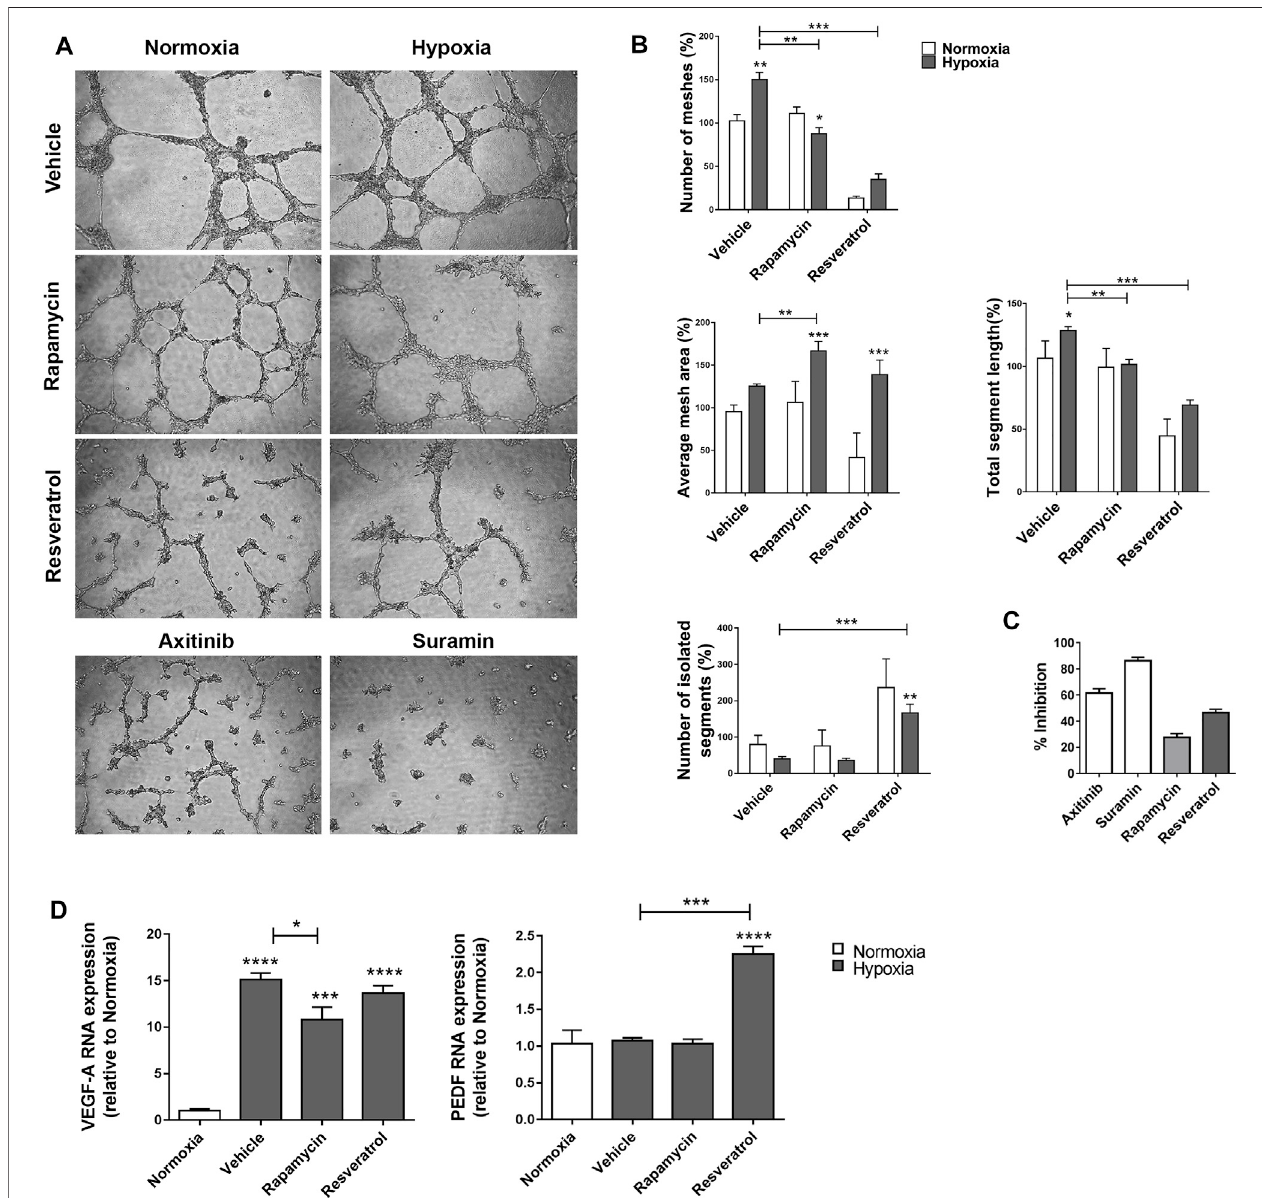
FIGURE 5 | Supernatants of MIO-M1 incubated with Rapamycin or Resveratrol inhibit BAEC tubulogenesis. (A) Contrast phase images of BAEC incubated with MIO-M1 supernatants in normoxic or hypoxic conditions during 8 h and in presence of vehicle, Rapamycin or Resveratrol. Axitinib and Suramin were used as positive control of tubulogenesis inhibition. (B) Quantitative analysis of the number and average area of meshes, total segment length and the number of isolated segments of BAEC performed with Image J Fiji Angiogenesis Analyser Software. (C) Percentage of tubulogenesis inhibition mediated by Suramin, Axitinib, Rapamycin or Resveatrol, respect to control. (D) VEGF and PEDF mRNA levels were quanti fi ed by qRT-PCR in MIO-M1 cells in normoxia or hypoxia and in presence of vehicle, Rapamycin or Resveratrol. Results were normalized to β -actin and expressed according to the 2 − ΔΔ Ct method using as calibrator the mRNA level obtained from normoxia. Graph shows results of three independent experiments. Data is presented as mean ± SEM. * p < 0.05, ** p < 0.01, *** p < 0.001, **** p < 0.0001.